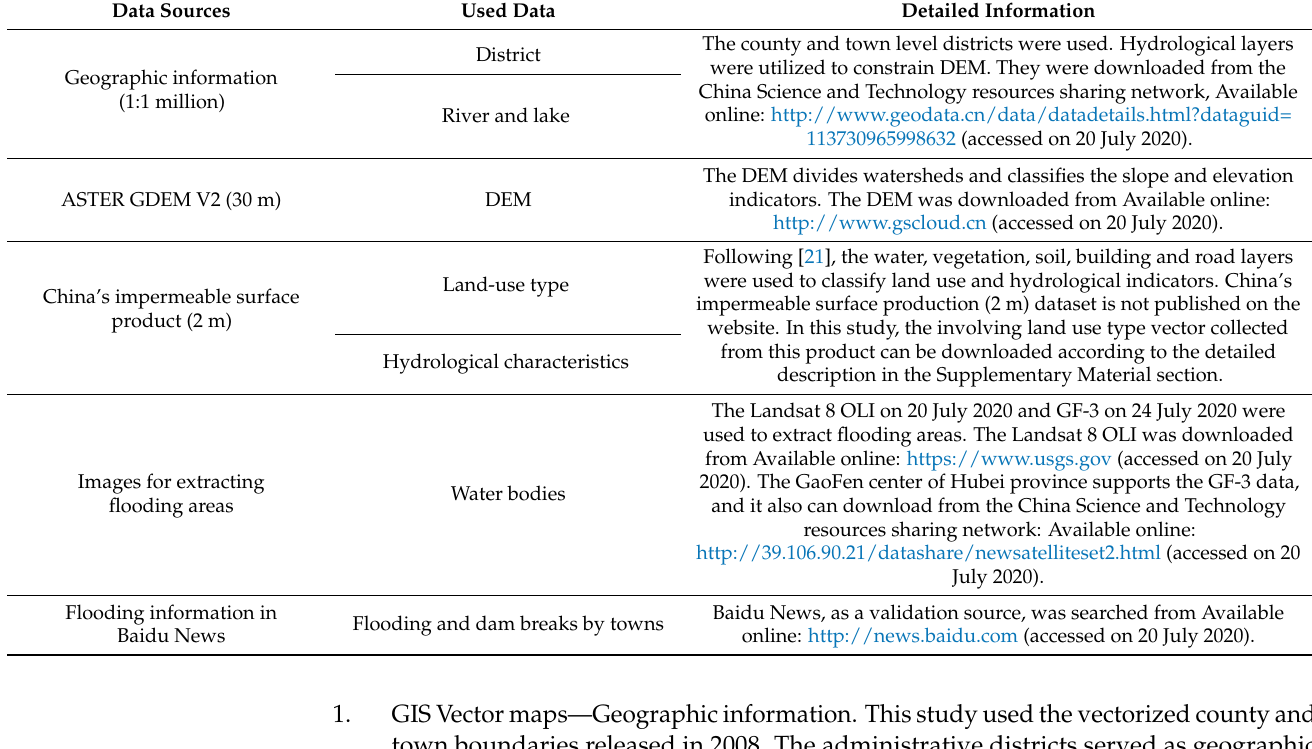
Table 1. The main data materials used in this